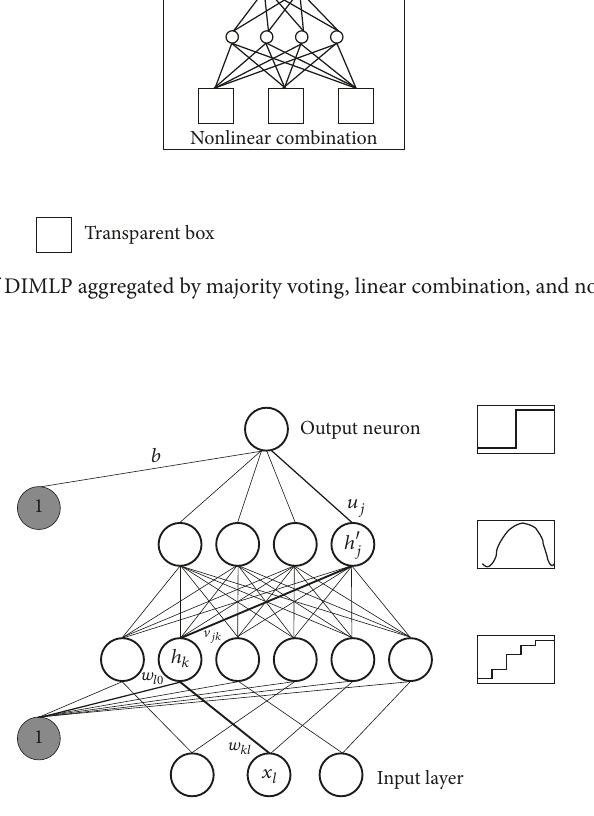
Figure3:AQSVMnetworkwithGaussiankernel.Thefirsthiddenlayerperformsaquantizednormalizationoftheinputs,whiletheincoming weights into neurons of the second hidden layer represent support